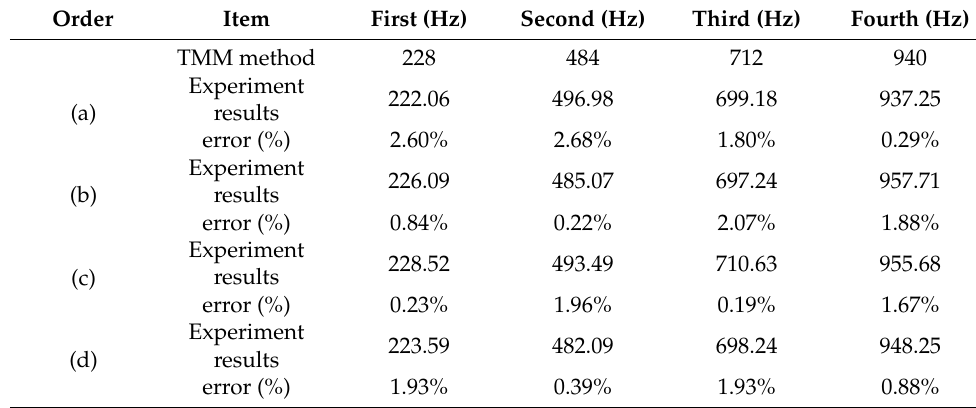
Table 11. Resonant frequencies of pipe (case 3).